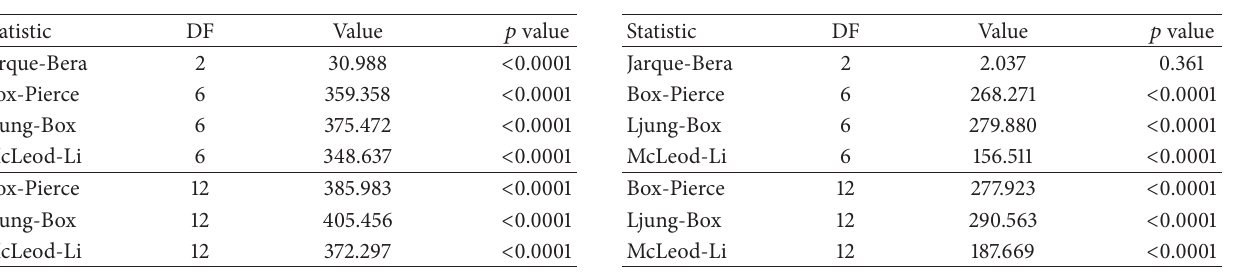
Table 1: Normality and white noise tests (CPI).